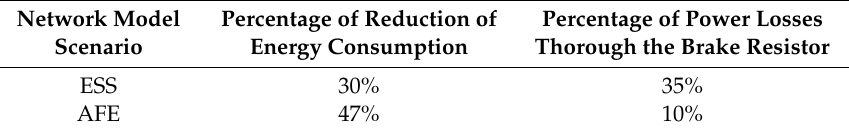
Table 5. Percentage of reduction of energy consumption and power